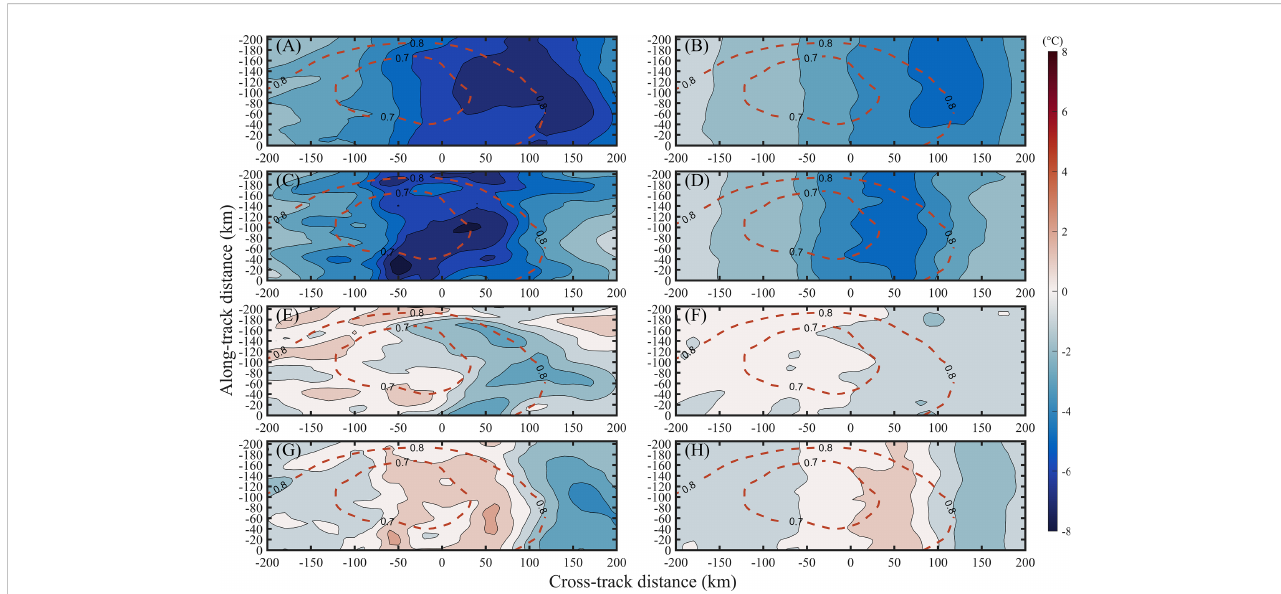
FIGURE 8 Modeled (A, B) SST anomalies and corresponding contributions of (C, D) mixing, (E, F) along-track advection and (G, H) cross-track advection to the SST anomaly within the de fi ned domain (see Figure 6 for the location) in EXP HYCOM (A, C, E, G) and EXP CLIMAT (B, D, F, H) . Red dashed curves indicate the initial zeta contours (0.7 m and 0.8 m) before the passage of the typhoon. Along-track distances of 0 and -200 km represent the east and west edges of the domain (see black box in Figure 6), respectively. Cross-track distances of -200 and 200 km represent the left and right edges of the domain (see black box in Figure 6), respectively.